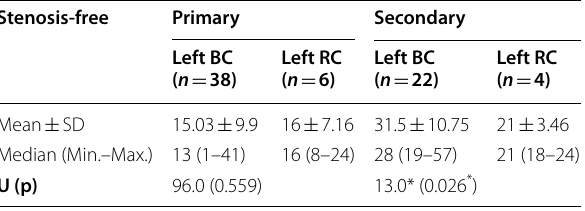
Table 5 Comparison between left BC and left RC according to stenosis-free